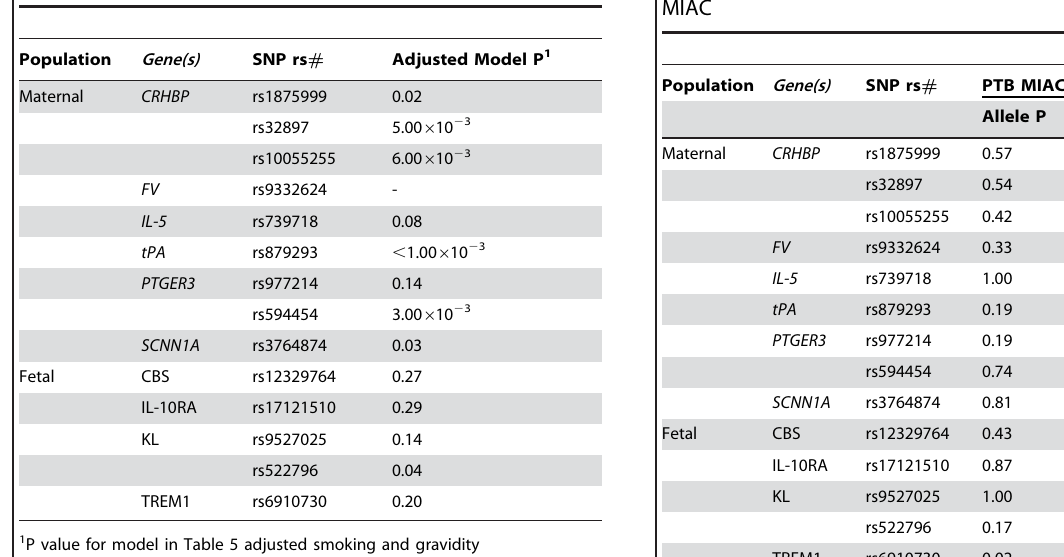
Table 6 . Single locus association analyses testing for allele and genotype differences between cases with and